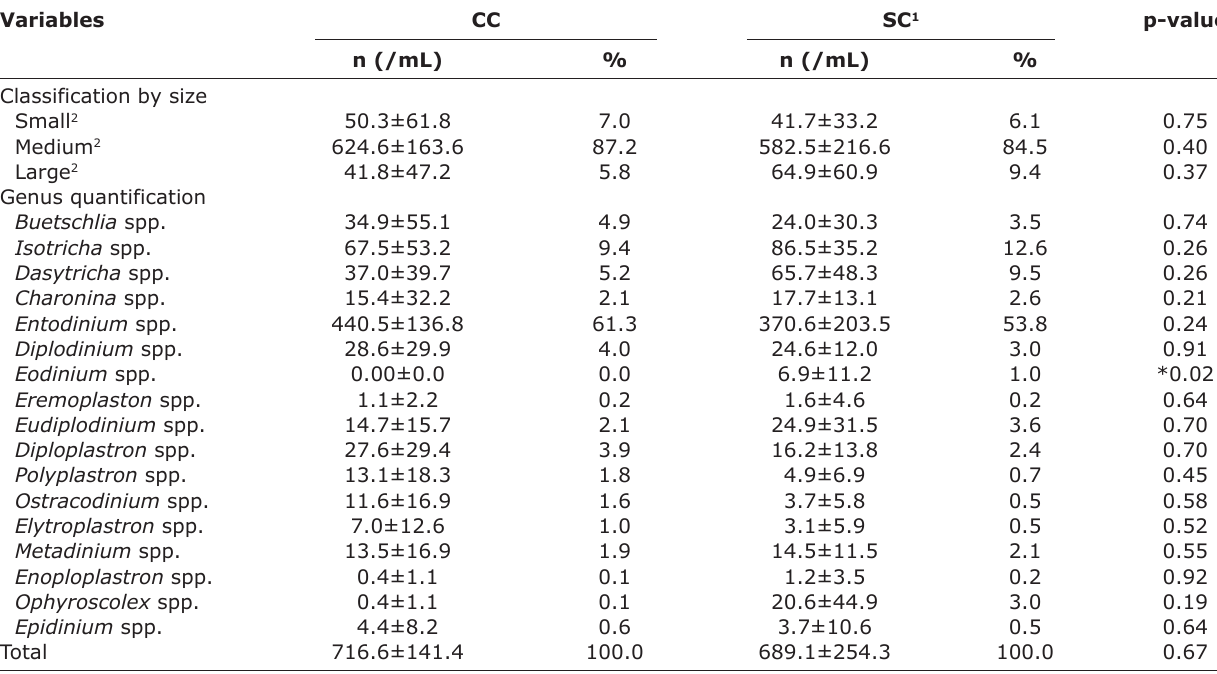
Table-6: Mean concentrations, standard deviations (SD), and distribution of protozoan sizes and genera in the ruminal fluid of Nellore calves supplemented (SC) or not supplemented (CC) with ruminal fungi. Variables